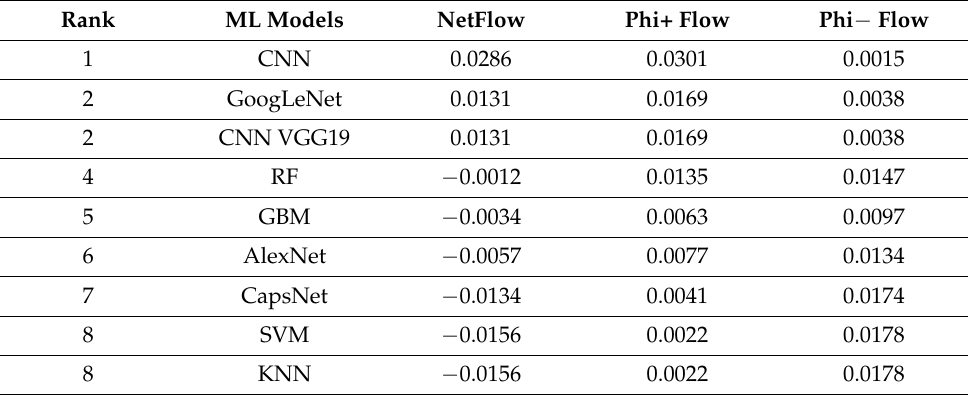
Table 5. Sensitivity analysis results with fuzzy PROMETHEE (support vector machine (SVM), random forest (RF), gradient-boosting model (GBM), convolutional neural network (CNN), K-nearest neighbor